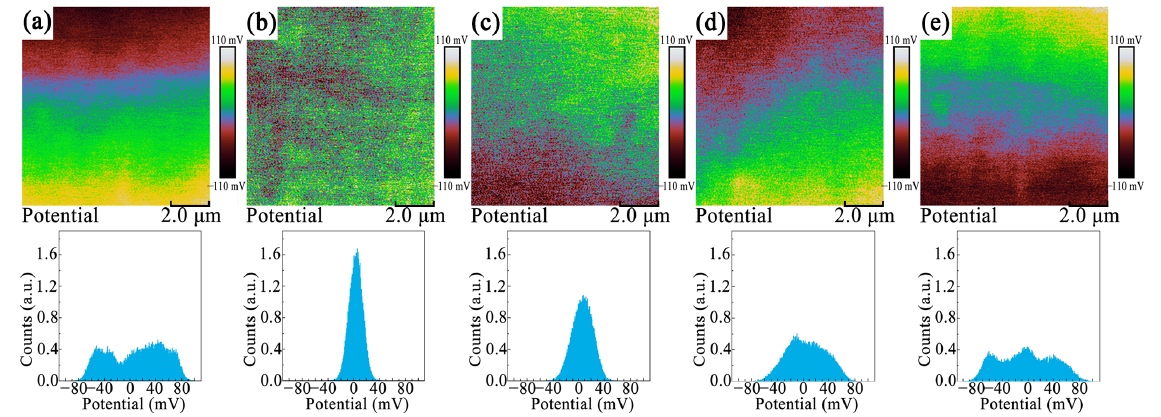
Figure 8. The surface potential maps and corresponding potential profile of NBT-BT-NN ceramics at different sintering temperatures ( a ) 1000 °C, ( b ) 1050 °C, ( c ) 1100 °C, ( d ) 1150 °C, ( e ) 1200 °C.